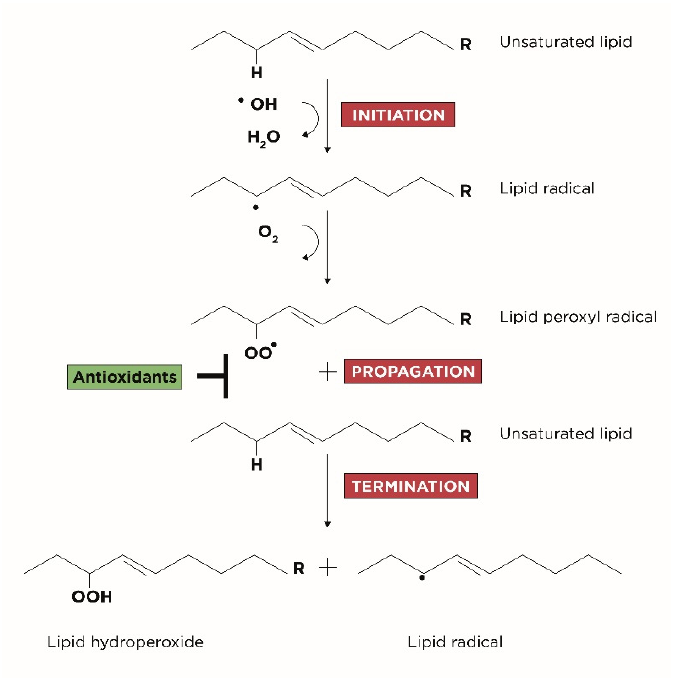
Figure 1. Three steps of LPO: initiation, propagation and